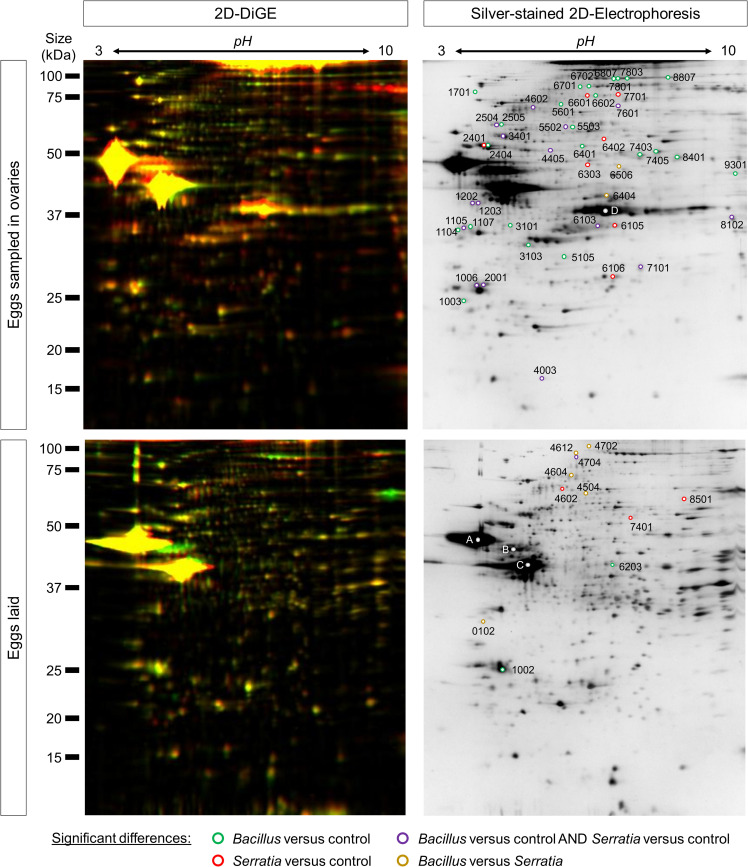
2D-gel electrophoresis highlights spots differentially abundant between priming conditions.Left panels: two-dimensional difference gel electrophoresis (2D-DiGE) with the three fluorescent channels corresponding to the three CyDyes (Cy5, Cy3 and Cy2) merged. Right panels: 2D-SDS-PAGE stained by mass spectrometry-compatible silver staining protocol are shown for eggs sampled in ovaries (top gels) or sampled within 16 h post-laying (bottom gels). Eggs were collected 3 days after female priming. Spots significantly (p < 0.05, Mann-Whitney test) 1.5 differentially abundant in eggs from B. thuringiensis compared to control, S. entomophila compared to control, both B. thuringiensis and S. entomophila compared to control and B. thuringiensis compared to S. entomophila are represented by green, red, yellow and purple circles, respectively. The same color code is used in Table 2 presenting a summary of proteins identified. A full list of the proteins identified and associated statistics is available in S3 Table. Six biological replicates per condition, each containing 70–74 eggs, for a total of 433 eggs from 117 different females were included in the 2D-DiGE analysis.